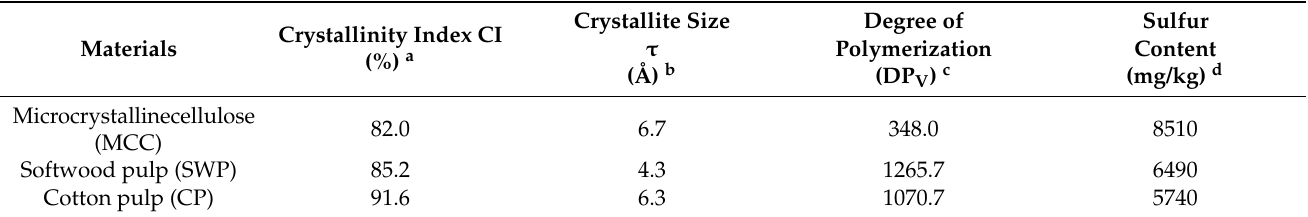
Table 2. Segal crystallinity index, crystallite size and degree of polymerization from diverse raw materials.